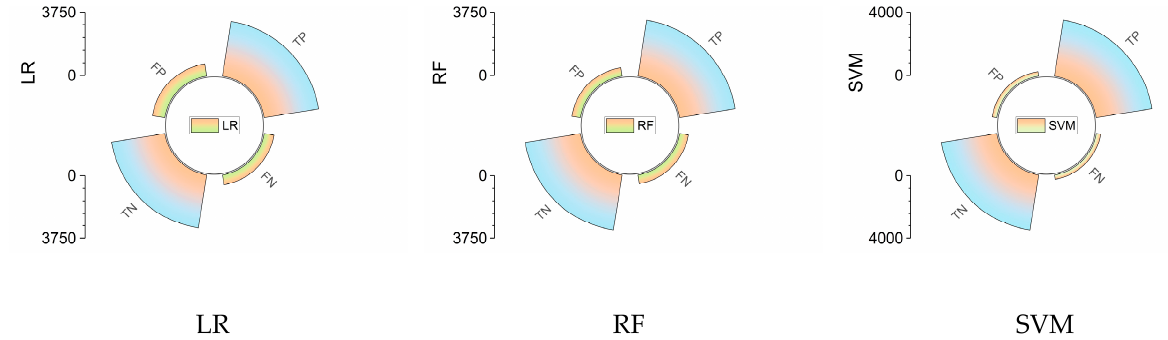
Figure 12. Distribution of TN, FN, FP, and TP for different model prediction results.